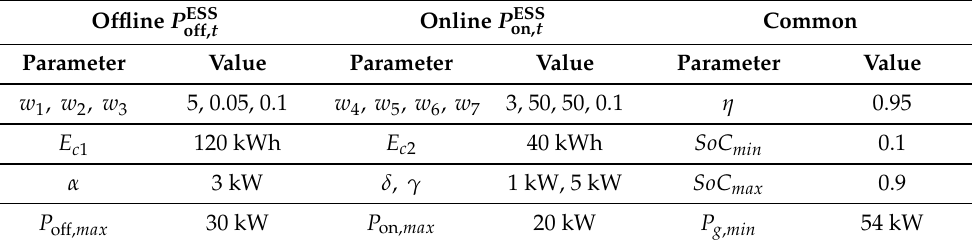
Table 2. Parameters for ESS